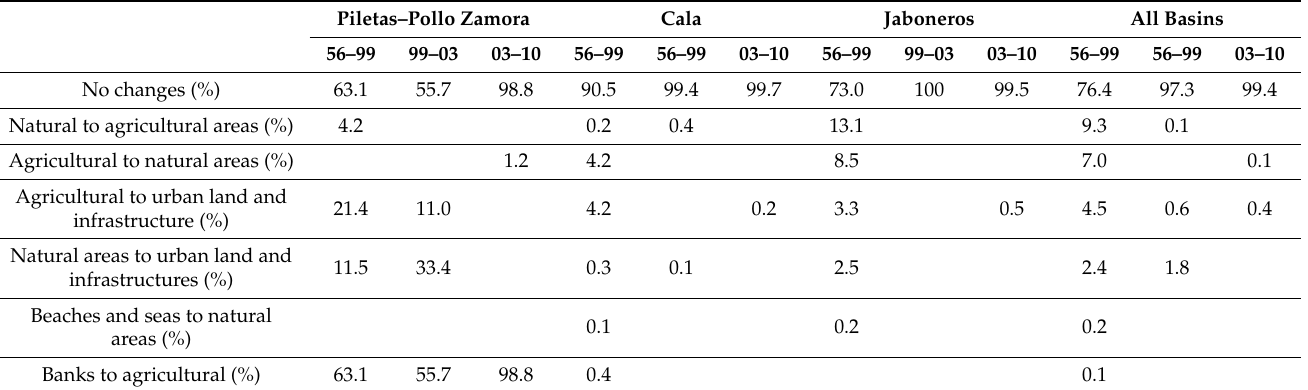
Table 9. Area of the basin that change land use between 1956, 1999, 2003, and